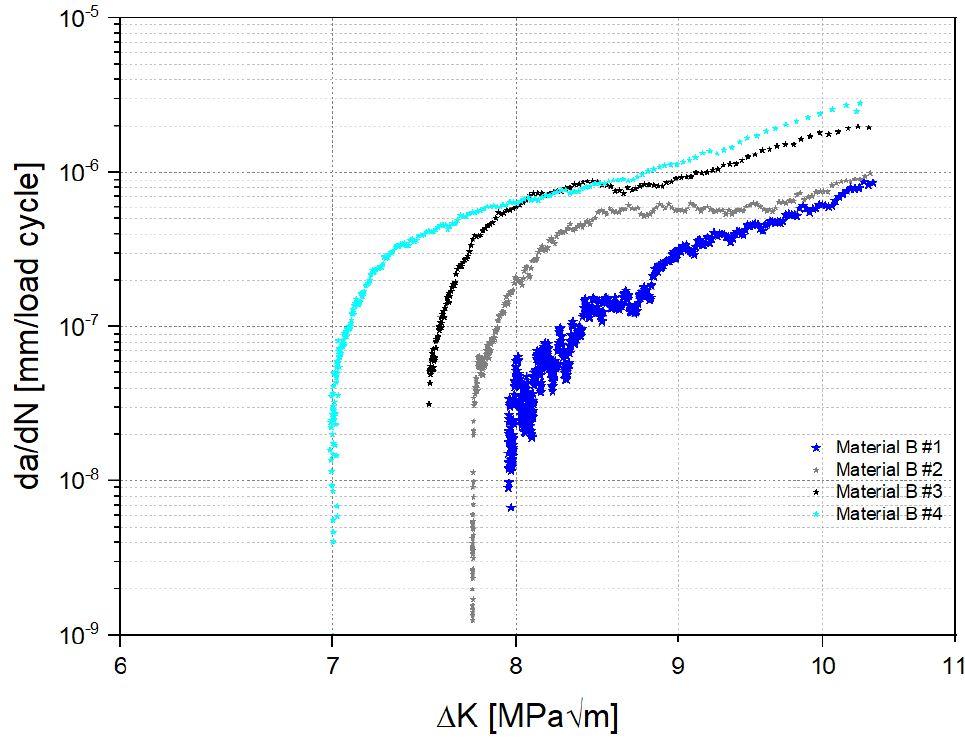
Figure 3. Fatigue crack growth curves for Material B; ECD: 9.29 mm; ALA: 28.66 mm; UTS: 1466 MPa; K IC : 128 MPa √ m—not valid.